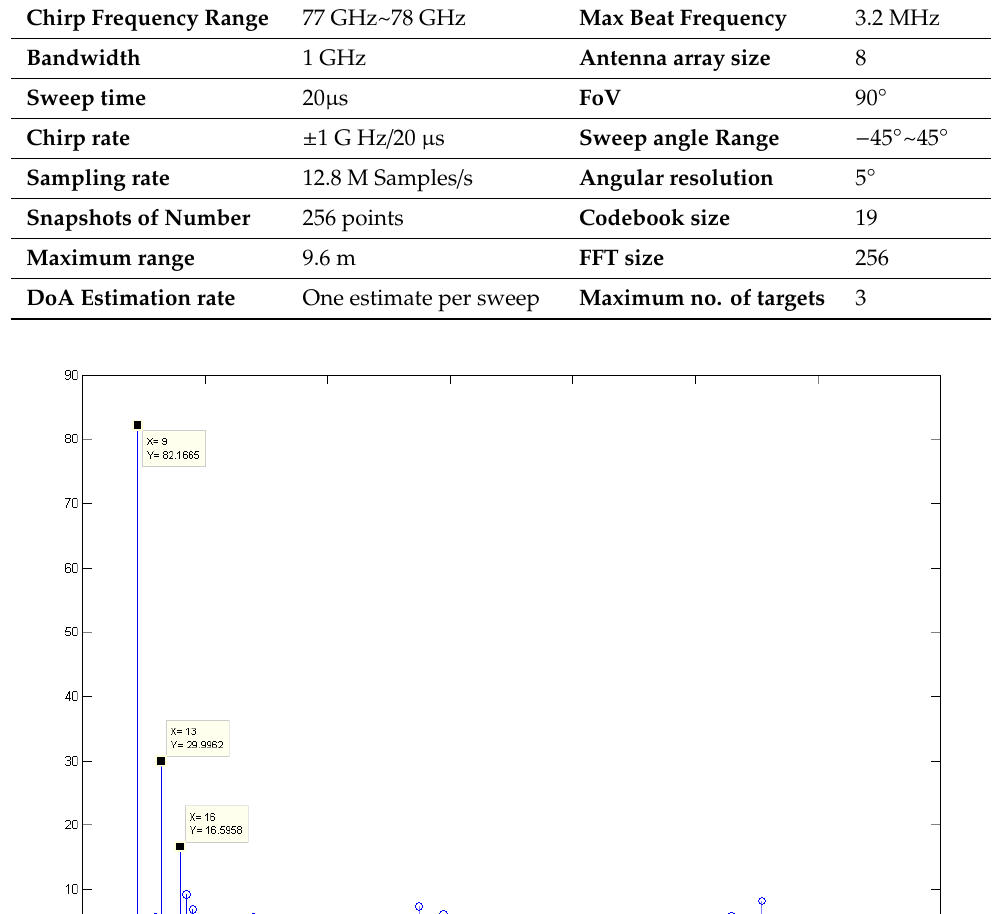
Table 3. Specifications of the radar system and the design requirements of the DoA estimation.